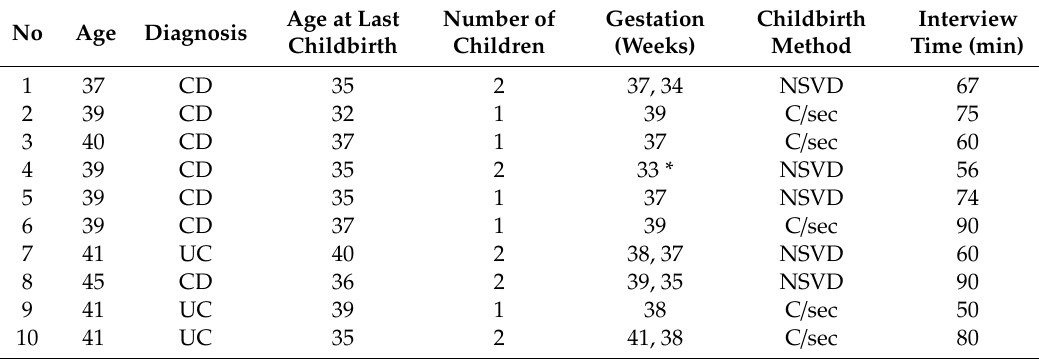
Table 1. Characteristics of the participants in in-depth interviews.